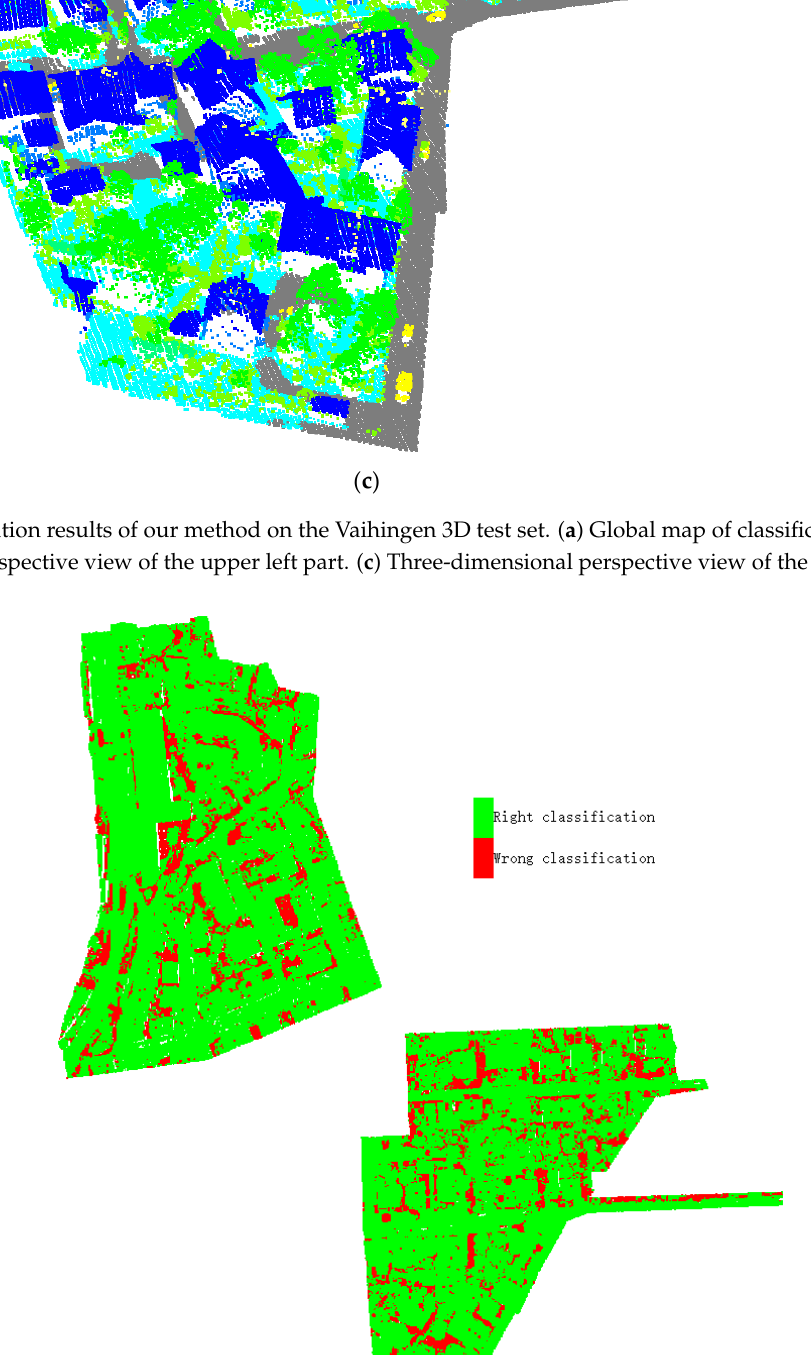
Figure 8. The error map of our method on the Vaihingen 3D test set.